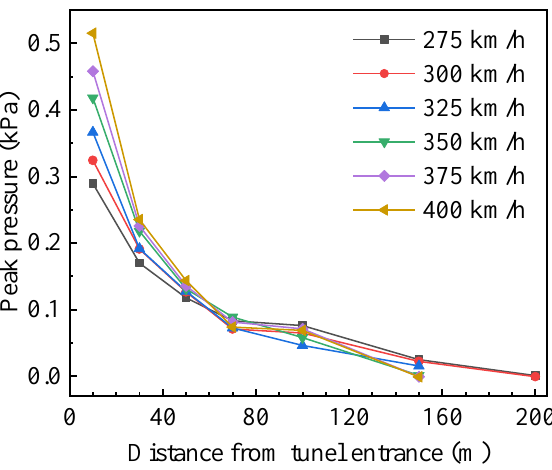
Figure 13. Peak pressure acting on tunnel vault along tunnel’s longitudinal axis in Stage